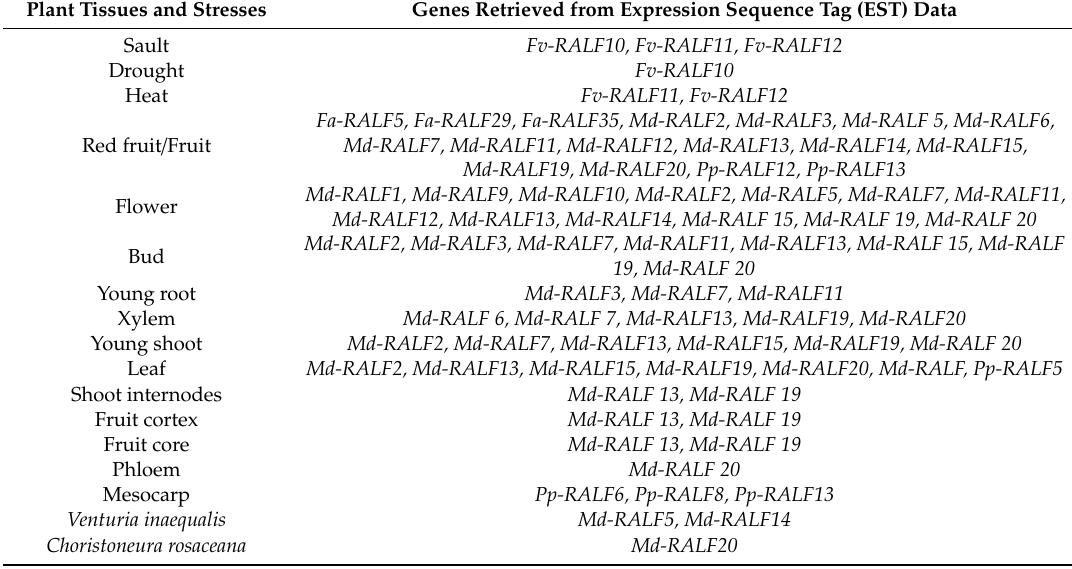
Table 2. The expression profile of RALF-like genes from seven Rosaceae species from EST data. Plant Tissues and